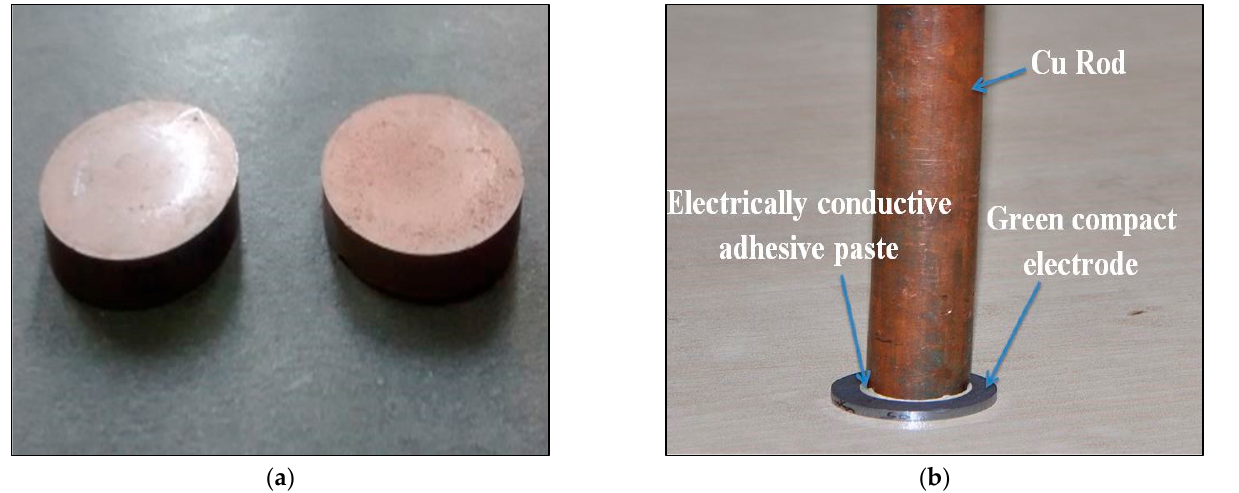
Figure 8. ( a ) Green compact electrode and ( b ) tool electrode extension